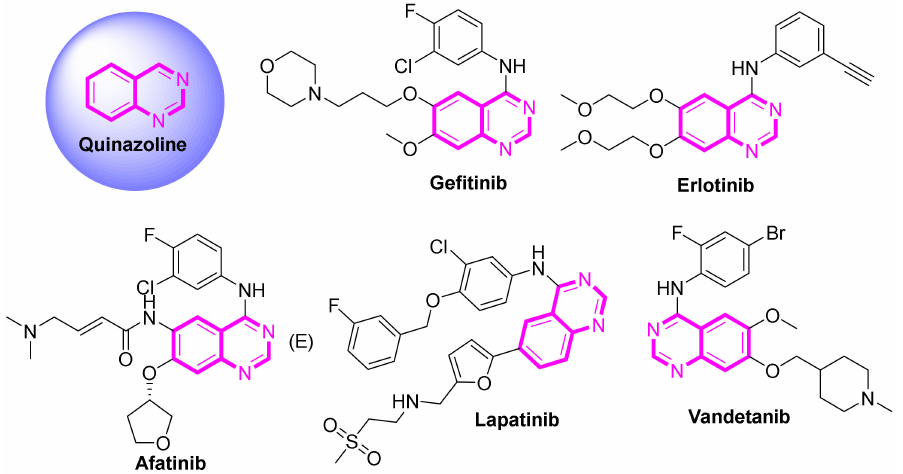
Figure 1. FDA approved quinazoline derivatives for cancer